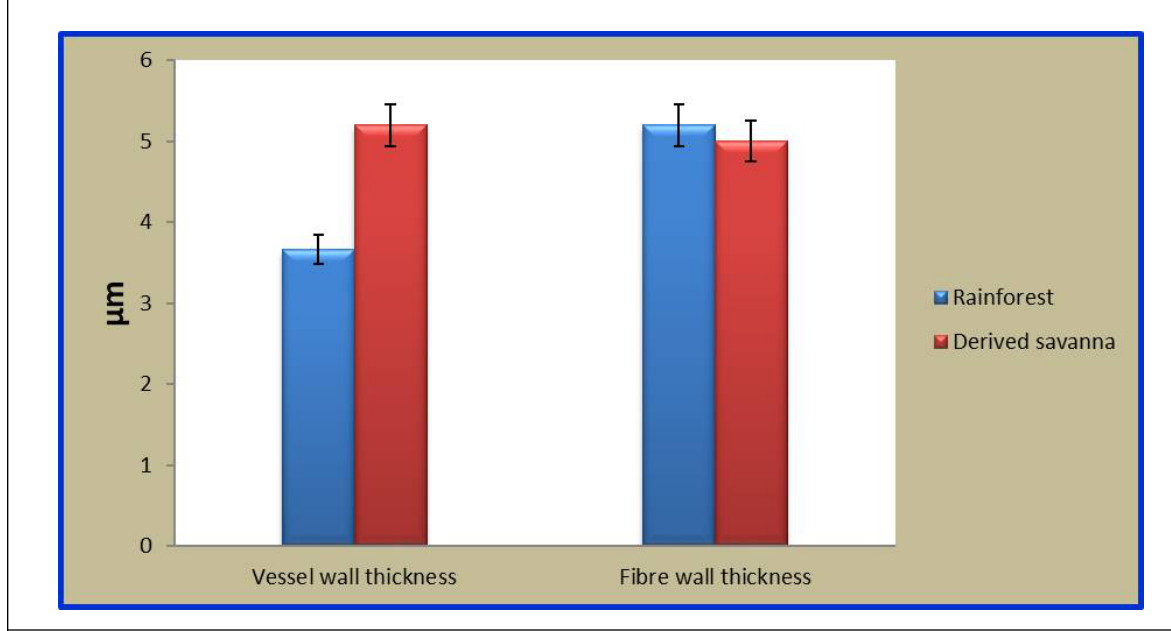
Figure 3: Vessel and fiber wall thickness of B. sapida growing in the rainforest and derived savanna regions of Edo